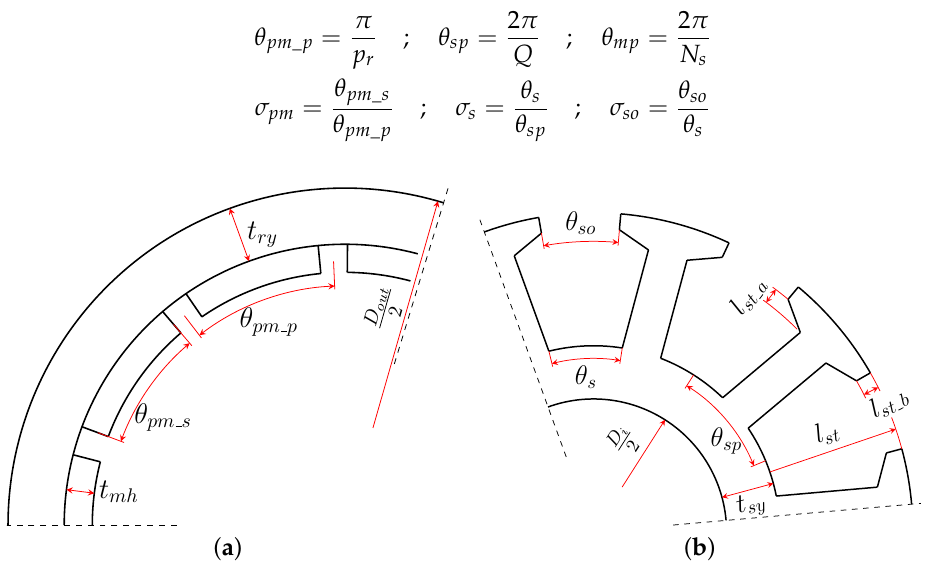
Figure 12. Machine geometric optimization variables of ( a ) rotor and ( b ) stator (©[2020] IEEE. Reprinted, with permission from